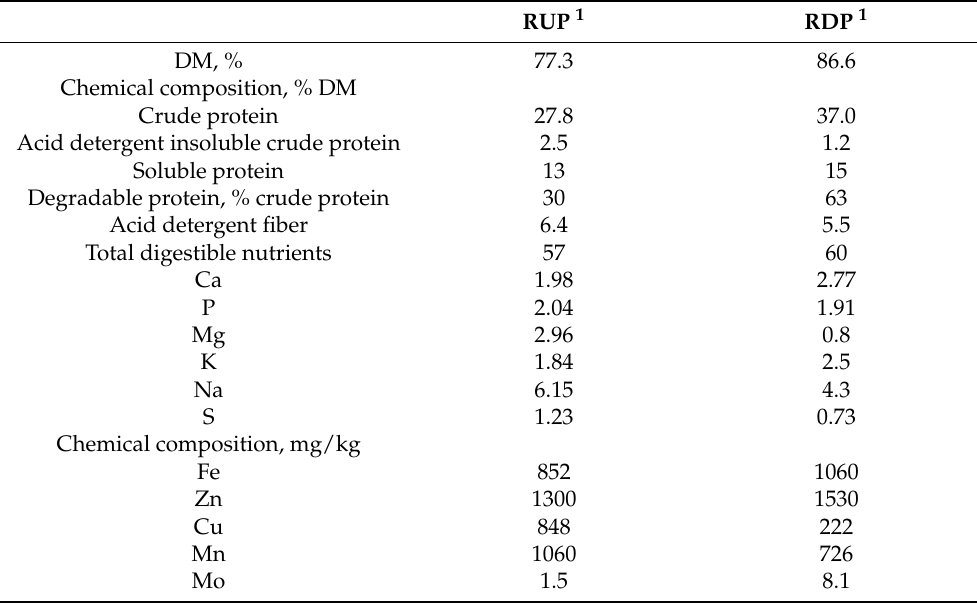
Table 1. Nutrient analysis of supplement offered ad libitum to yearling, and 2- and 3-year- old cows in Smart Feed Pro Trailers while grazing improved dryland